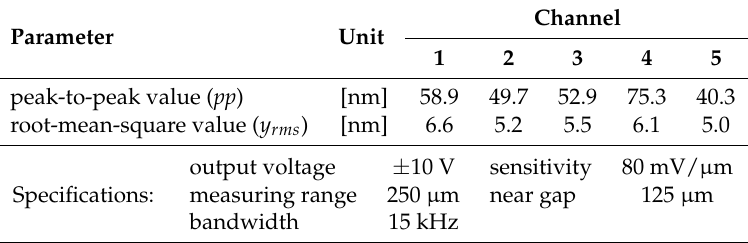
Table 2. Technical and calibration data of capacitive displacement measurement